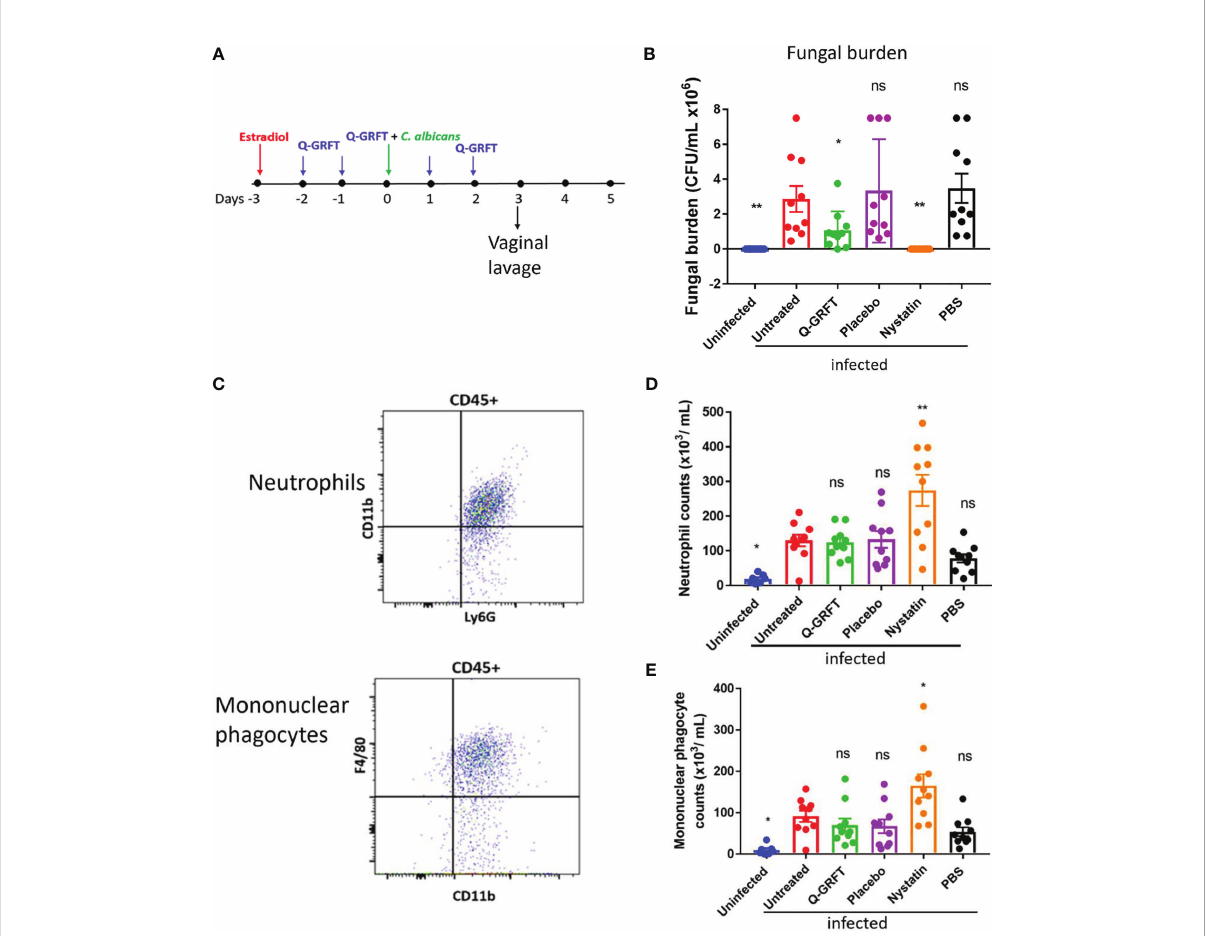
FIGURE 1 Q-GRFT signi fi cantly inhibits vaginal fungal infection in a preventive model of murine candidiasis. (A) Experimental scheme. CBA/J mice (N= 10 per group) were estradiol-treated at Day -3, followed by twice daily instillation of either Q-GRFT gel, nystatin solution, PBS, or Carbopol placebo gel per vaginum for the next 5 days. At Day 0, mice were inoculated with 20 µL of (C) albicans blastospores at a cell concentration of 1.0 X 10 8 CFU/mL, per vaginum. A vaginal lavage was performed 24 hours after the fi nal dose administration. (B) Vaginal fungal burden (CFU/mL) following treatment, for mice in (A) . Each dot represents one mouse, N=10 mice per group. Experiments were performed and repeated at least 2 times, and representative data of Mean ± SEM is shown. (C) Flow cytometry gating strategy for neutrophils, and mononuclear phagocytes in the vaginal lavage. Neutrophils were identi fi ed as CD45 + Ly6G + CD11b + , while monocytes were CD45 + CD11 + F4/80 + cells. (D) Neutrophil and (E) mononuclear phagocyte cell populations in the vaginal lavage following the respective treatments. N=10 animals per group, and each dot represents a population of cells from a single mouse. Measurements are representative of cell populations from experiments performed at least 2 times. Mean ± SEM data is presented. For all experiments , one-way ANOVA was used for statistical analyses, and P ≤ 0.05 was considered signi fi cant. For normality testing, Dunnet ’ s test (B) , and Tukey ’ s test (D, E) were performed for respective datasets. For all datasets, all groups were compared to infected untreated controls. 'ns' = p> 0.05; *p=or < 0.05 and '**' = P< or =